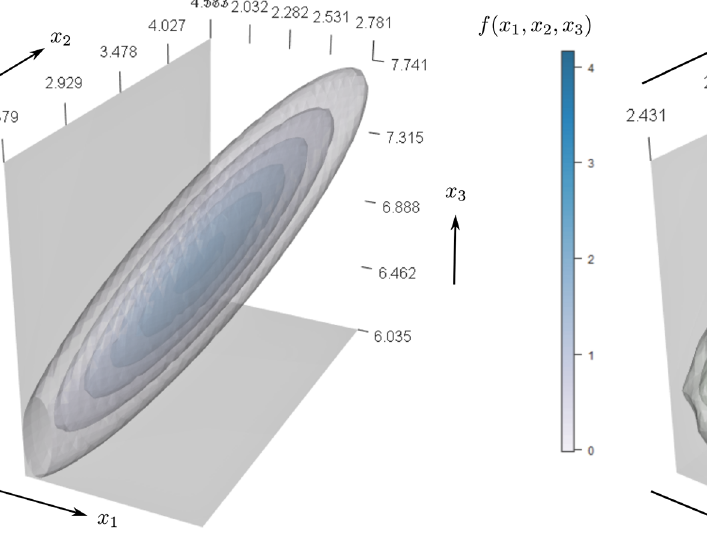
Fig. 3. Volumetric isosurfaces density visualization of the equivalent Rosenblatt transformation